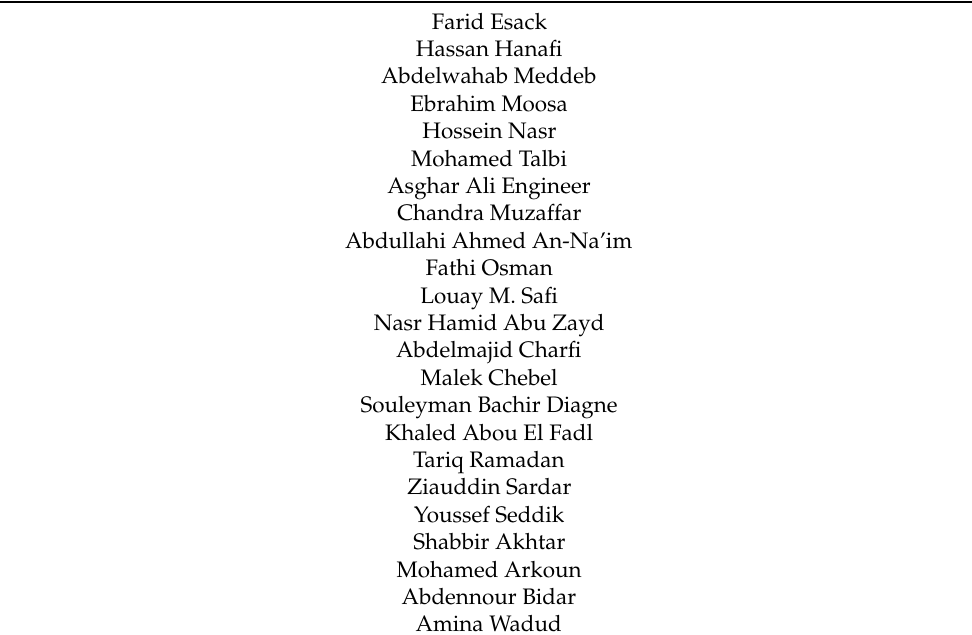
Table 2. The 23 Authors Selected for Bibliometric